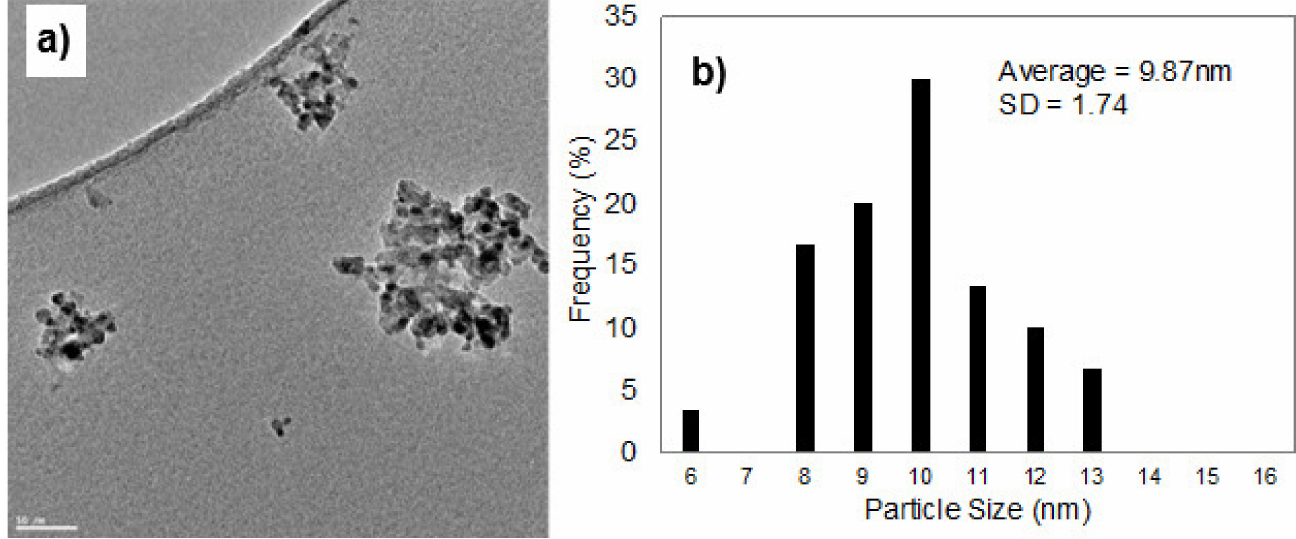
Figure 3. ( a ) TEM image of a calcined Cu/MgO/Al 2 O 3 catalyst; ( b ) Histograms of the particle size distribution determined from TEM image of a calcined Cu/MgO/Al 2 O 3 catalyst. Cu/Mg/Al (molar) =